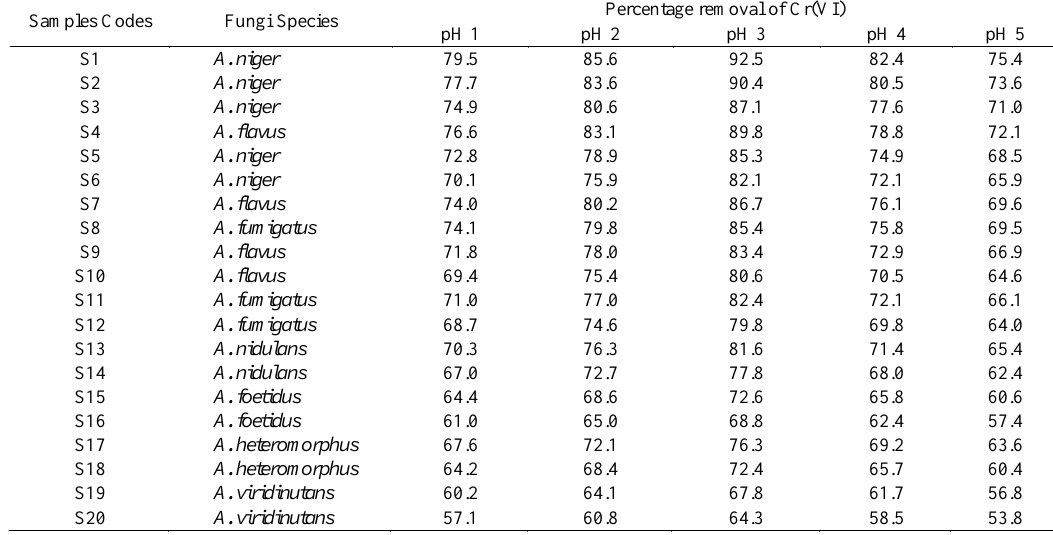
Table 4: Effect of pH in removal percentage of Cr(VI) in tannery industry wastewater by isolated fungi from tannery industry wastewater contaminated soil against an optimum incubation time of 7 days, fungus biomass of 1.0 g, and an initial Cr(VI) concentration of 290